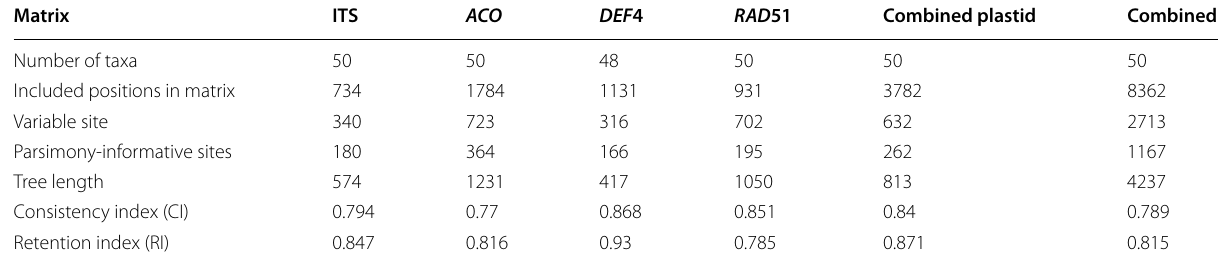
Table 2 Parsimony statistics for phylogenetic analyses from single and combined datasets